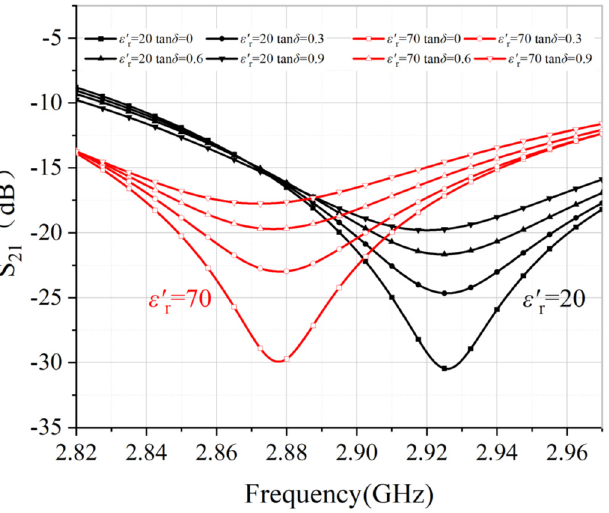
S Figure 7. Variation of S 21 (dB) magnitude of the sensor with loss tangent value ranging from 0 to 0.9 Figure 7. Variation of 21 (dB) magnitude of the sensor with loss tangent value ranging from 0 to for ε (cid:48) r = 20 and ε (cid:48) r = 70. 0.9 for